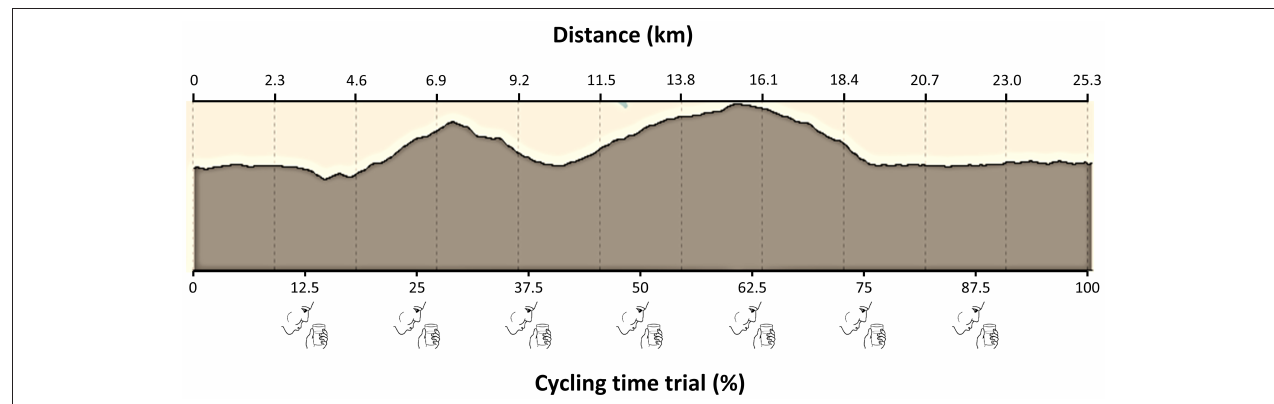
FIGURE 1 | Profile of the cycling time trial (25.3 km). Participants mouth-rinsed with a 6.4% carbohydrate beverage or a tasted-matched non-caloric placebo beverage during the trial.